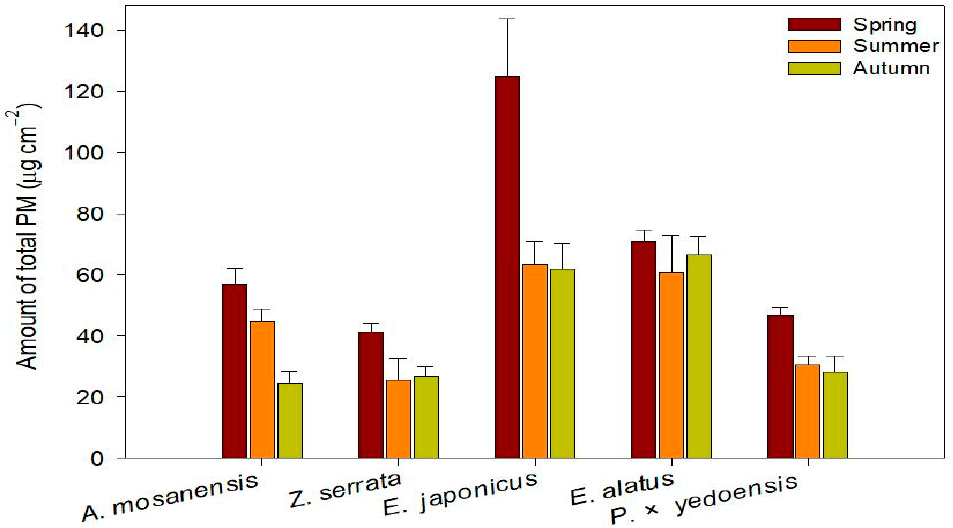
Figure 2. The total PM accumulation on leaves of five plant species in three seasons (spring, summer and autumn).